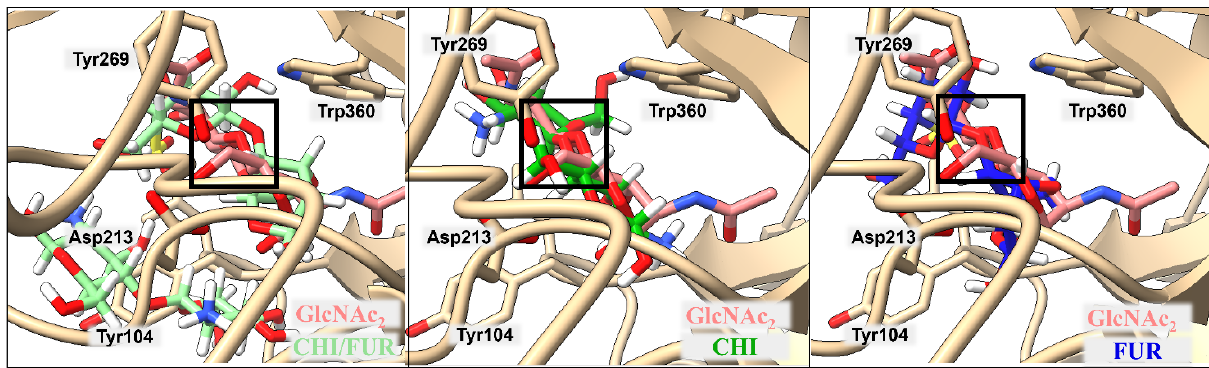
Figure 6. Comparison of CHI/FUR, CHI, and FUR ligand positions obtained by docking with the native GlcNAc 2 molecule in complex with the 4P8V structure. The glycosidic bond overlap is highlighted in the black box—Cartesian coordinates of atoms in the box are provided in the Supplementary Materials.